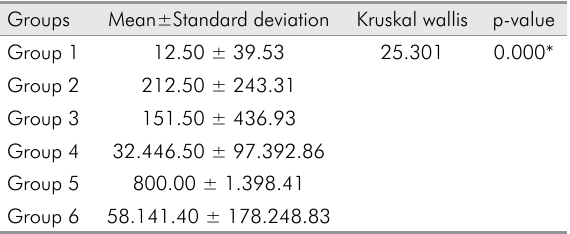
Table 3. The results of Kruskal Wallis test performed regardless of the type of the